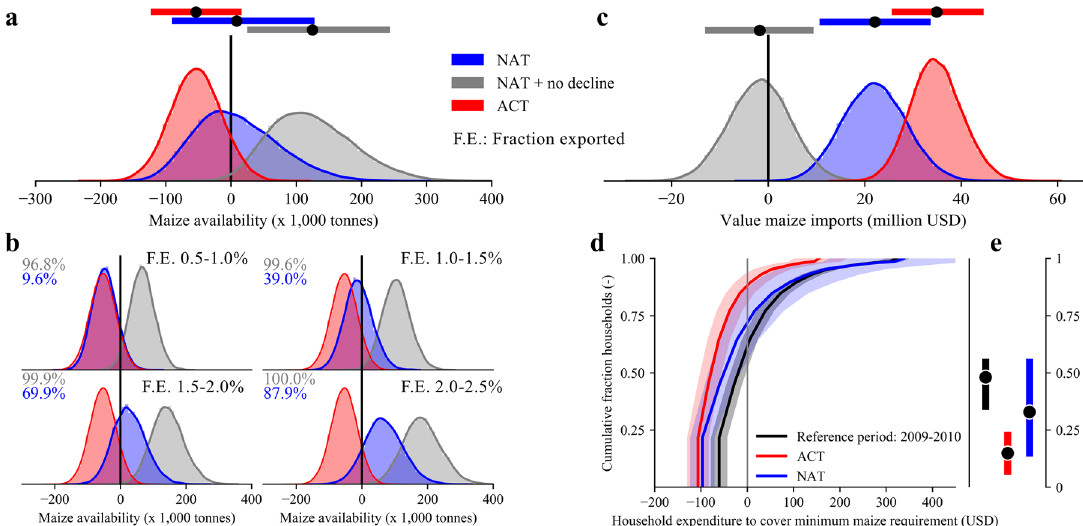
Figure 3. Illustrative plot showing the sensitivity of the food security situation in Lesotho to the 2007-like drought event. ( a ) Probability density plots of the availability of maize to cover minimum consumption needs using the probabilistic model for the ACT (red) and NAT (blue). The horizontal bars at the top illustrate the mean (black marker) and 10–90% uncertainty range of the distribution. The grey distribution plot is the NAT result added to a scenario without no trend in maize deficit in Lesotho. ( b ) A breakdown of plot ( a ) under four different ranges of the fraction of exports (F.E., exports from South Africa to Lesotho over total production South Africa) with the numbers in blue and grey representing the probability of having a positive maize availability value. ( c ) The monetary value of maize imported from South Africa to cover minimum consumption needs in Lesotho. A negative value indicates that the minimum consumption is satisfied, and the surplus maize can be either consumed or sold. ( d ) The cumulative distribution plot of the household expenditure for 13 groups of farming households with varying sizes of farmland operation. The black line is based on the 2009–2010 Agricultural Census of rural households, and the red and blue lines show the model results for the statistical model using the ACT and NAT conditions. The thick line is the mean value and the filled shading the 10–90% uncertainty range based on the 50,000 realizations of the model. ( e ) The fraction of rural households that are self-sufficient in meeting their minimum maize requirement for the reference period (2009–2010), compared to those under ACT and NAT